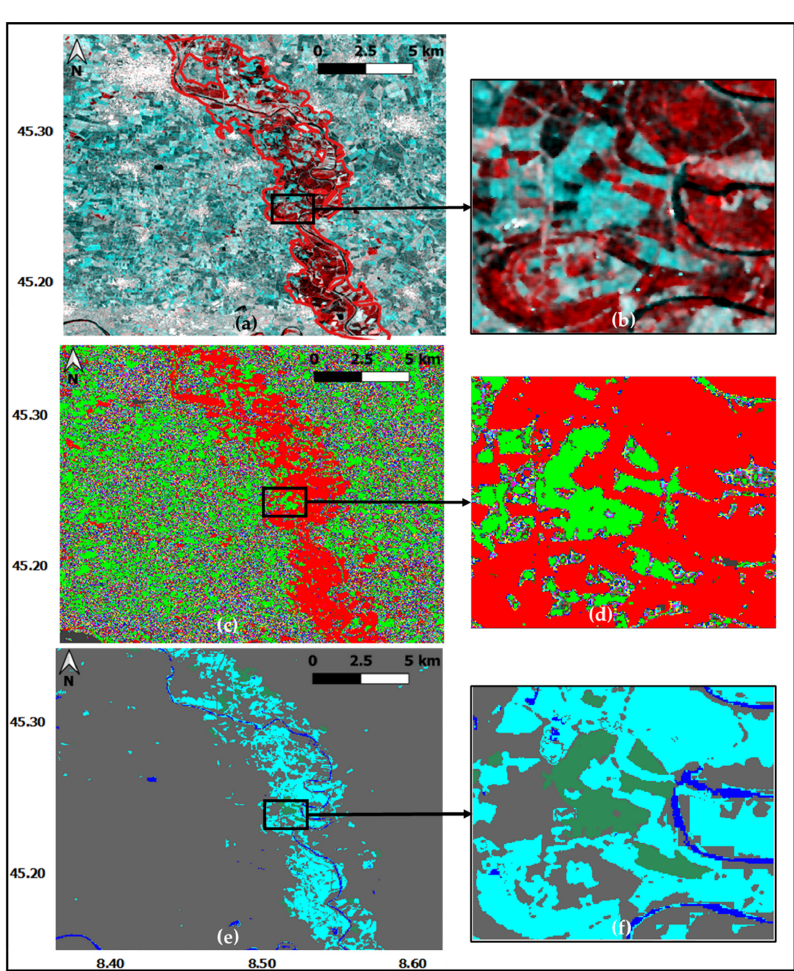
Figure 13. Example of the results of the method to map flooded vegetation implemented in AU- TOWADE for the Vercelli test case. Panel ( a ): RGB false color image produced using the S1 data (red: pre-flood image, green/blue: flood image) with, superimposed in red, the boundaries of the flooded area detected using S2 data; panel ( c ): output of the ISODATA applied to ∆ σ 0 (green: cluster of the VV objects with high ∆ σ 0 ); panel ( e ): map of open floodwater (cyan), flooded vegetation (sea green) VV and permanent water (blue); panels ( b , d , f ): zooms on flooded vegetation. Table 5. Comparison between CEMS-derived and AUTOWADE-derived open floodwa- ter/permanent water maps in terms of kappa coefficient and F1-score. The latter has been computed as the arithmetic mean over individual F1-scores considering all the classes (3rd column), or only the two water classes (4th